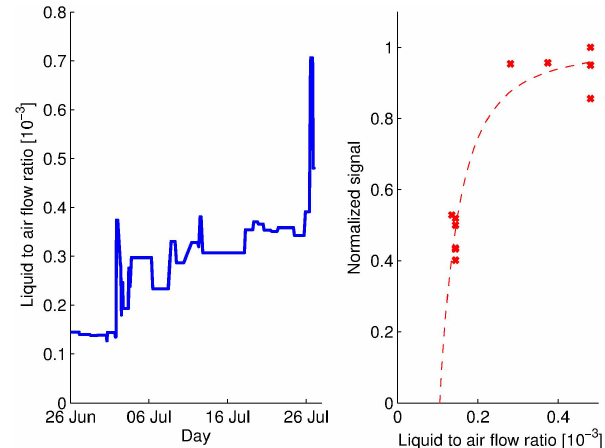
Fig. 3. Calibration plots for ammonia (NH 3 , left panel) and dimethylamine (DMA, right panel). Grey areas correspond to the range of experimental data.